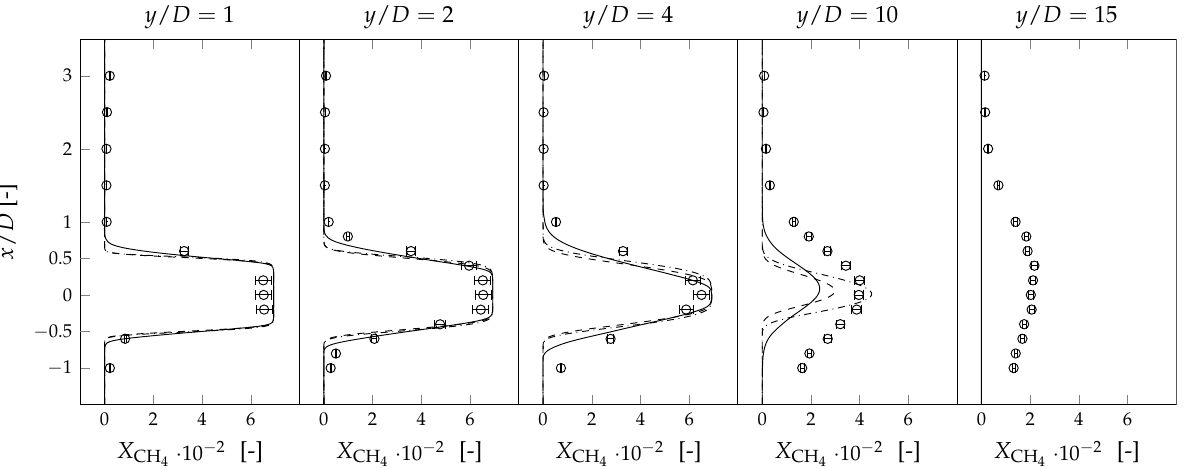
Figure 15. Mean molar fraction of CH 4 at various stream-wise locations. FGM-NAC (——), FGM-NA (– – –), FGM-A (–·–·–), Raman measurement results ( ◦ ) [2].